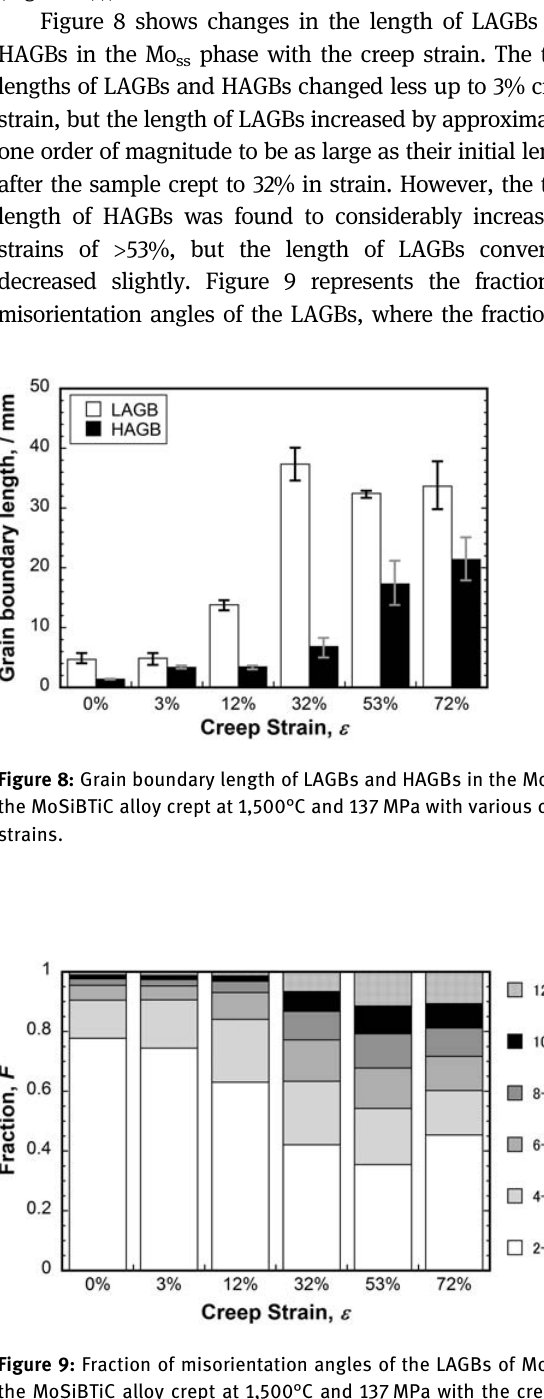
Figure 10: Pole fi gures of the T 2 phase in the MoSiBTiC alloy crept at 1,500°C and 137 MPa with various creep